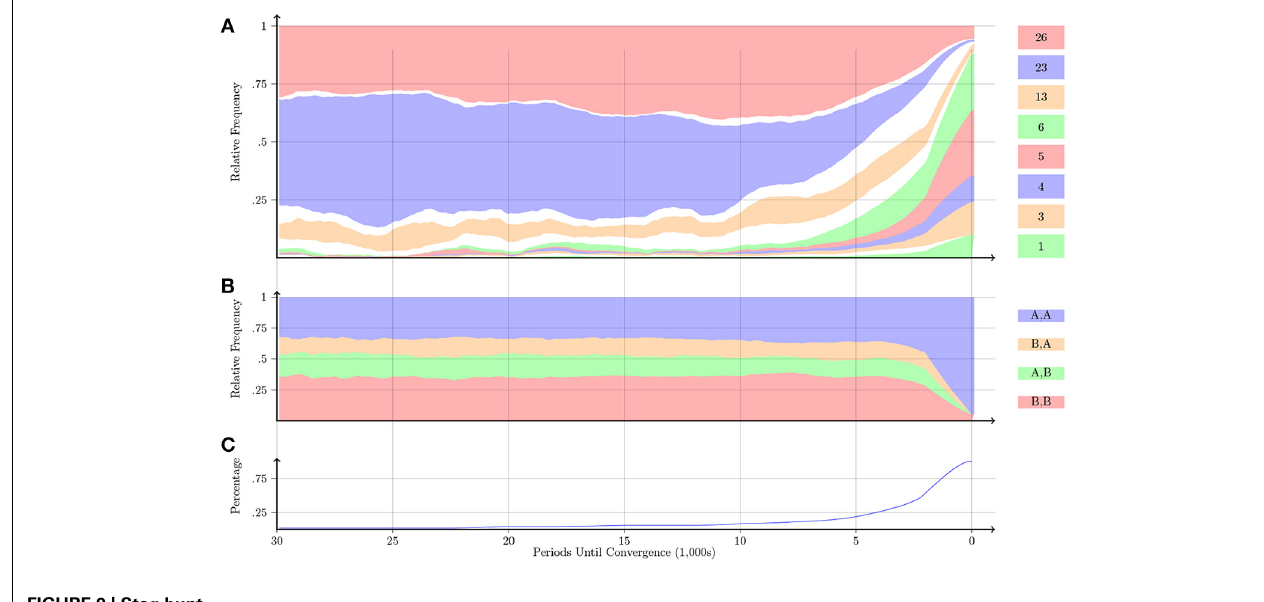
FIGURE 9 | Stag hunt.